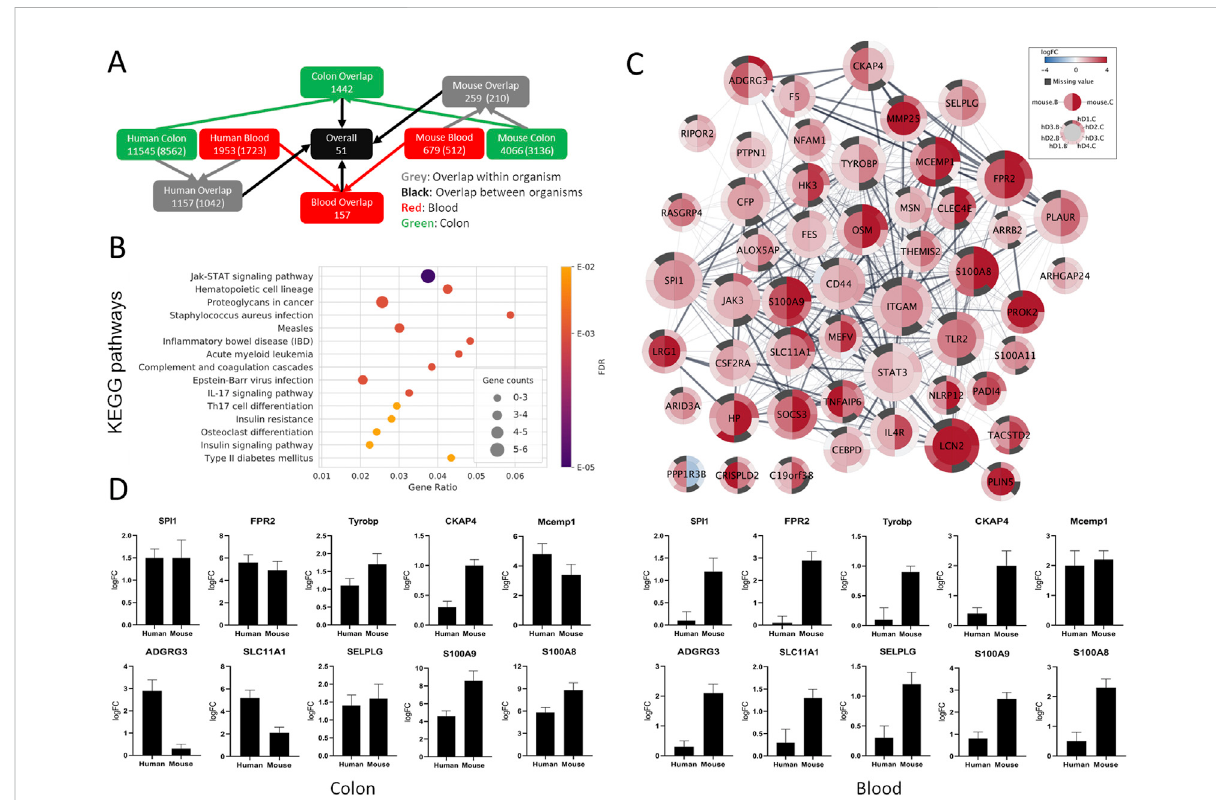
FIGURE 3 Comparison between SDE genes of human and mouse UC. (A) Gene overlap diagram between human combined sets and mouse colon and blood SDE genes with padj ≤ 0.05. The total number of genes in the sets and orthologous genes (in parenthesis) is shown. (B) Top 15 enriched KEGG pathways for the common SDE genes between human, mouse colon, and blood. Gene ratio corresponds to the ratio between the number of common SDE genes in mouse-human and all human genes in the pathway. The dot size indicates the SDE gene number (gene counts), while the color represents the enrichment signi fi cance given by the FDR adjusted p -values. (C) Differential gene expression visualization on the STRING network of genes shared between mouse (inner node circle) and human (outer node circle) in the blood (left node half) and colon (right node half). log2FC values are shown with a blue-white-red gradient, and dark grey color indicates missing values. The size of the nodes corresponds to their network importance as measured by a combination of degree, closeness, and betweenness centrality. (D) To validate the expression level of a few selected genes common in the colon and blood of human and mouse UC, qRT-PCR was performed. S100A8 and S100A9 were used as positive in fl ammatory